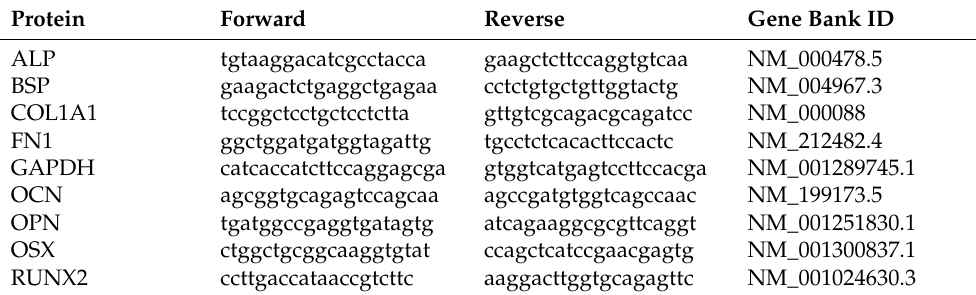
Table 2. PCR primer sequences of genes implicated in different osteogenic